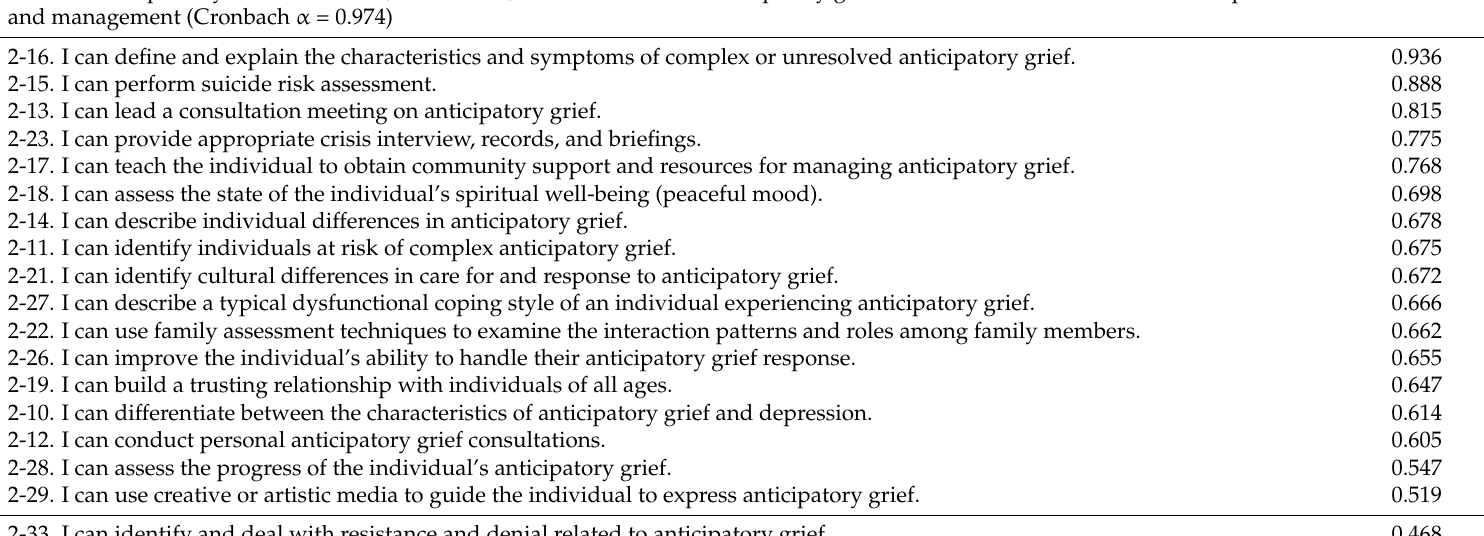
Pattern Structure Corrected Item-Total Matrix Matrix